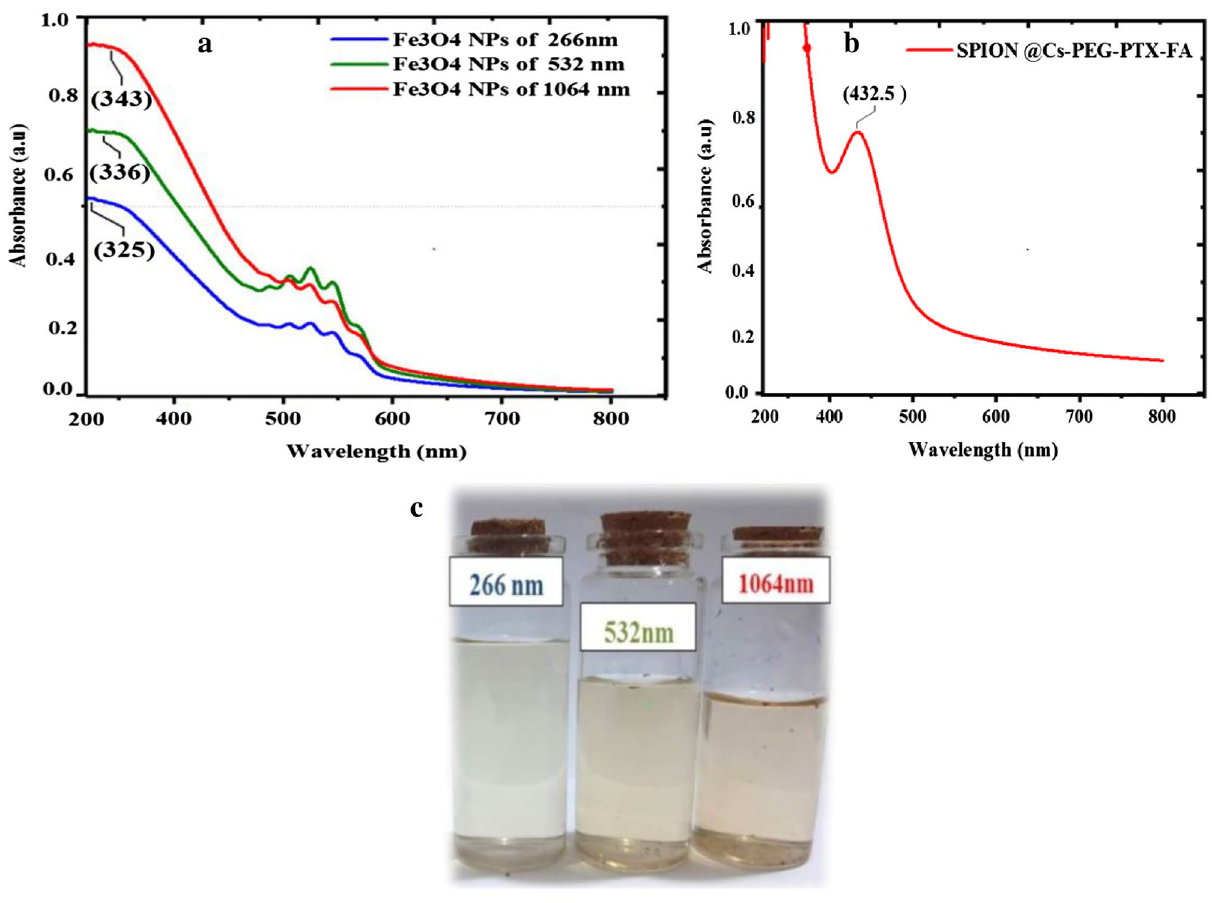
Figure 5. UV-Vis spectrophotometry absorption indicates a maximum absorbance above 300 nm at different wavelengths (1064, 532, and 266 nm) at a fluence of 28 J/cm 2 in KMnO 4 solution in ( a ); ( b ) shows the 100% absorption for SPION after coating by Cs + PEG + FA with the drug PTX; and ( c ) shows a photograph of the colloidal Fe